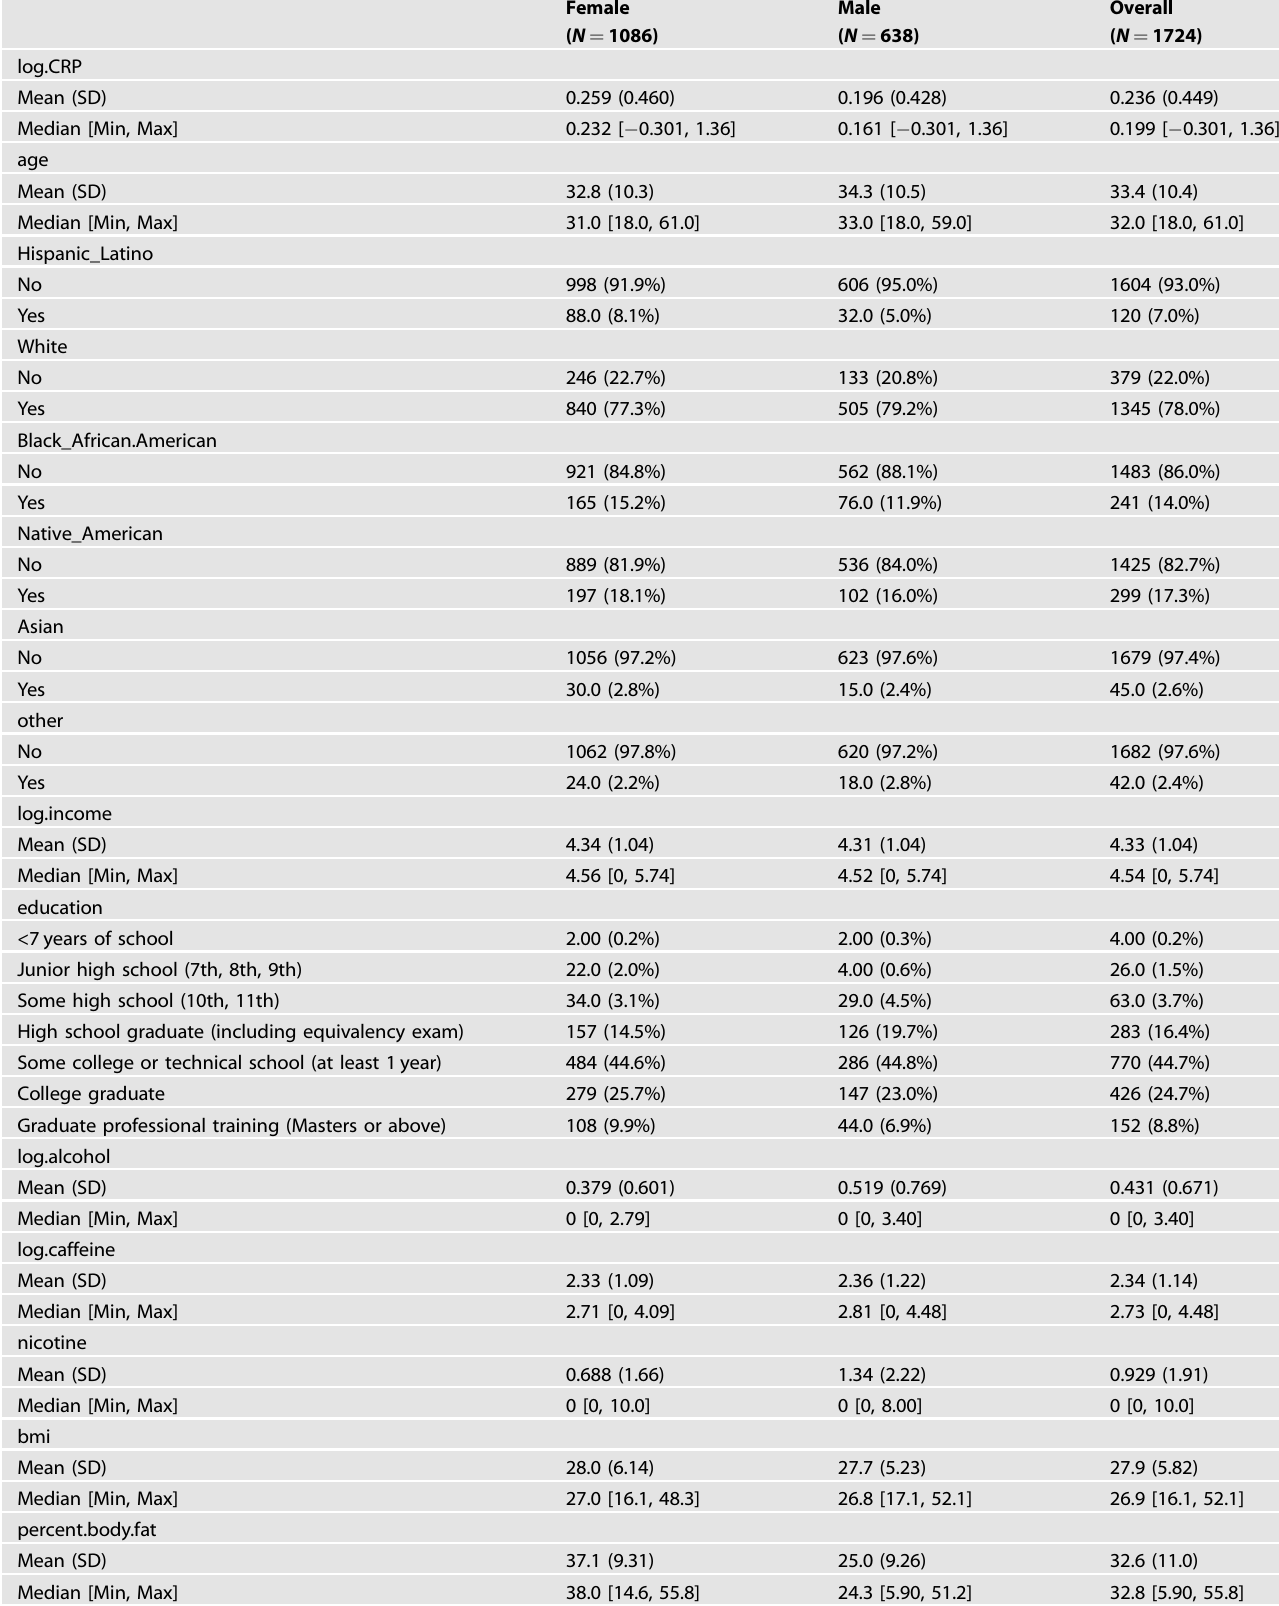
Table 1. Demographic and clinical